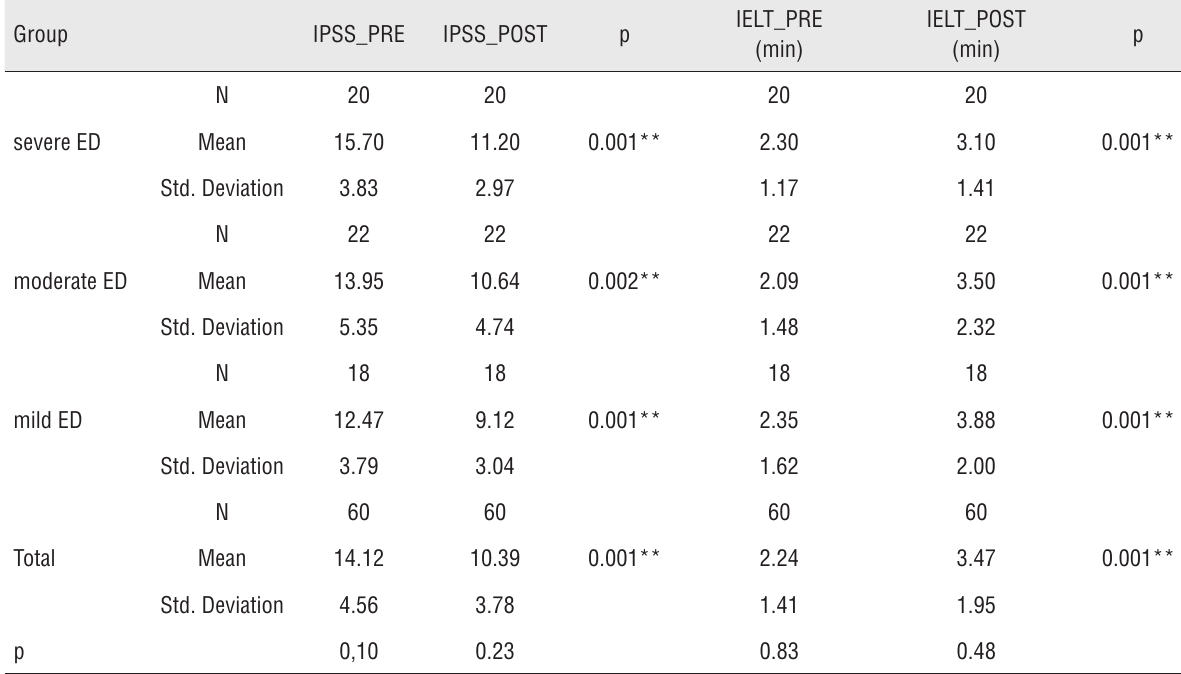
Table 3 - Comparison of ED groups in terms of IPSS and IELT scores before and after tadalafil 5 mg daily treatment. Group IPSS_PRE IPSS_POST